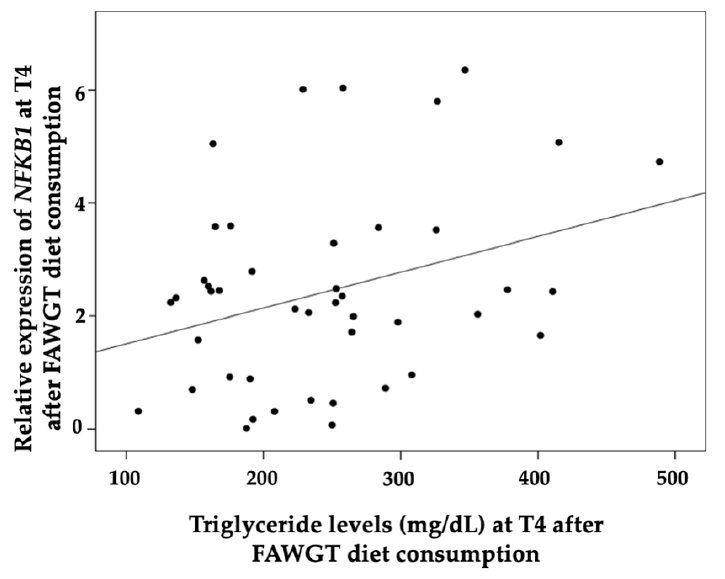
Figure 4. Correlation analysis between the gene expression of the inflammatory-related NFKB1 and triglyceride levels in the postprandial state at 4 h after 8 weeks of dietary intervention with a diet consisting of fruit, avocado, whole grains, and trout predominant in the Colombia coffee region (FAWGT). The correlation was evaluated with a Pearson bivariate correlation analysis using SPSS 20 for Windows software (SPSS Inc., Chicago, IL, USA). p < 0.05 was considered to be significant.